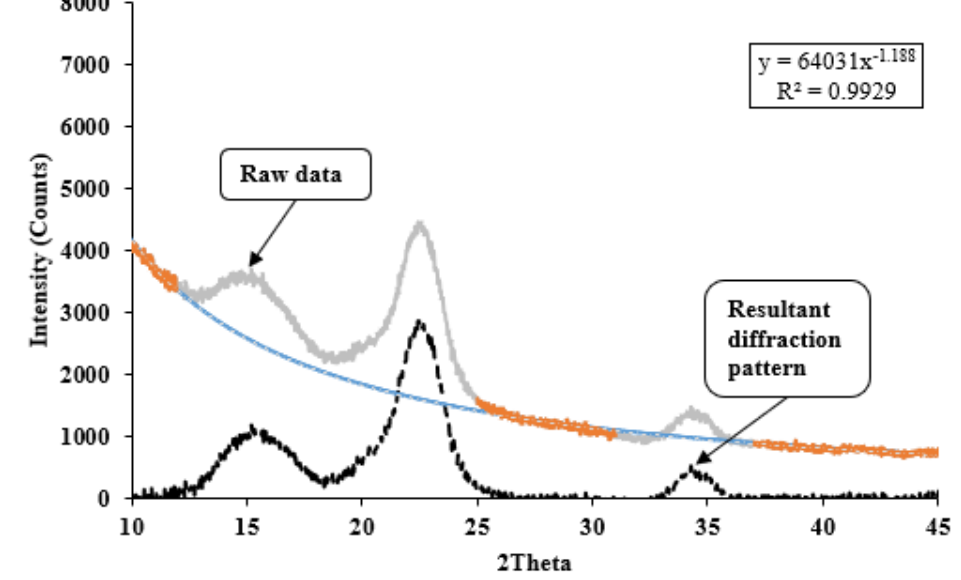
Figure 11. X-ray diffraction pattern of a hemp fibre mat using Cu Kα radiation.